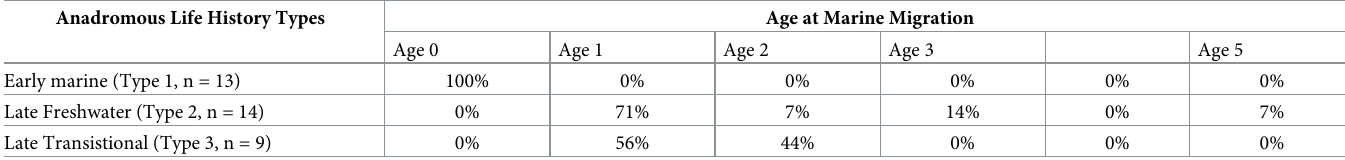
Table 2. Age at migration for anadromous life history types of Broad Whitefish ( Coregonus nasus ) caught in the Colville River, AK, USA. Anadromous Life History